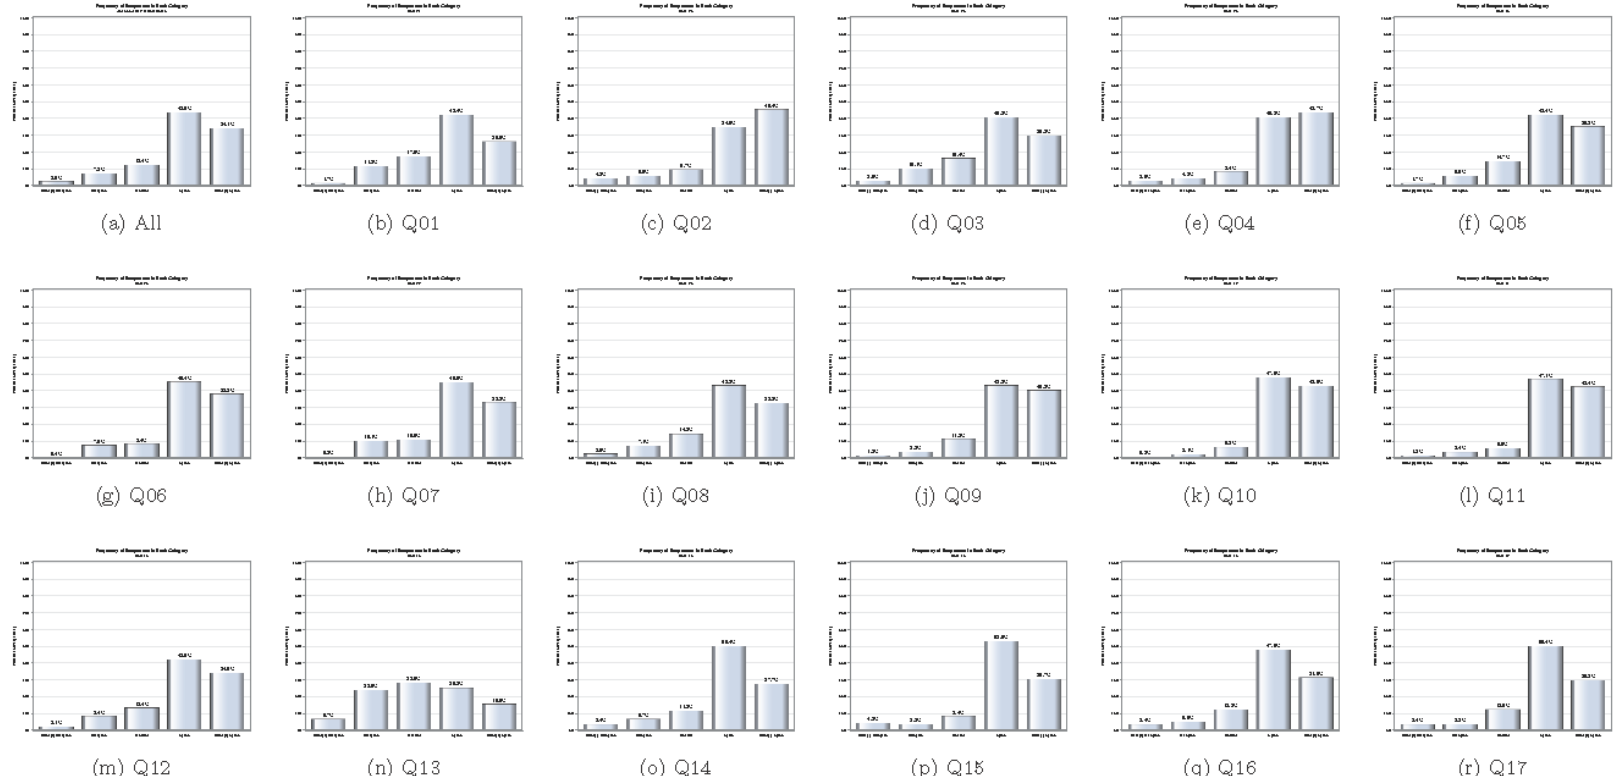
Figure 1 . Response frequency distributions for all and individual